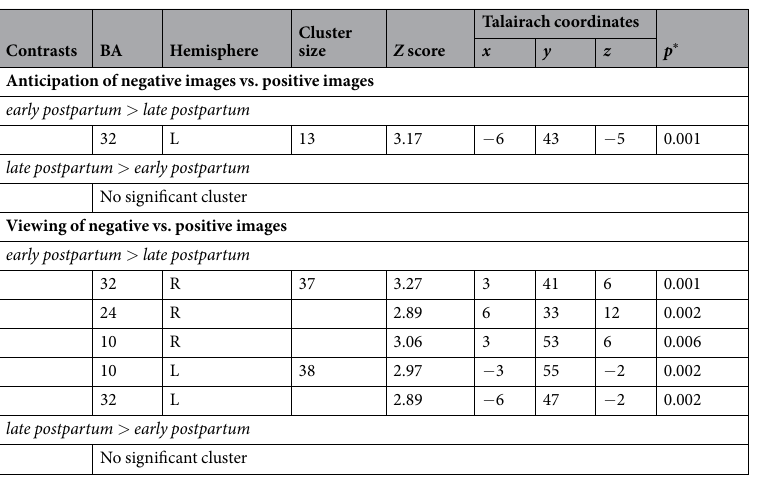
Table 1. Differences between the early (within 48 h) and late postpartum (after 4–6 weeks) period in blood oxygen level–dependent reactivity during anticipation of negative emotional stimuli and viewing of emotional stimuli, N = 11. * Corrected for multiple comparisons across the search volume of the region of interest with an extent threshold cluster size ≥